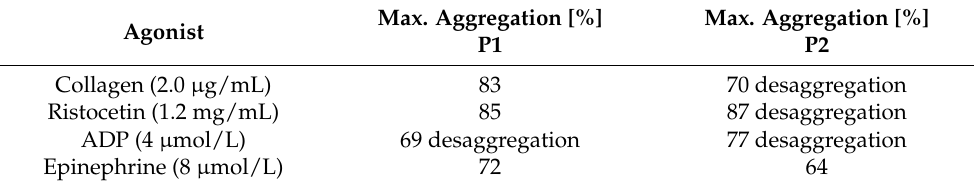
Table 1. Platelet aggregometry analyses for P1 and P2.